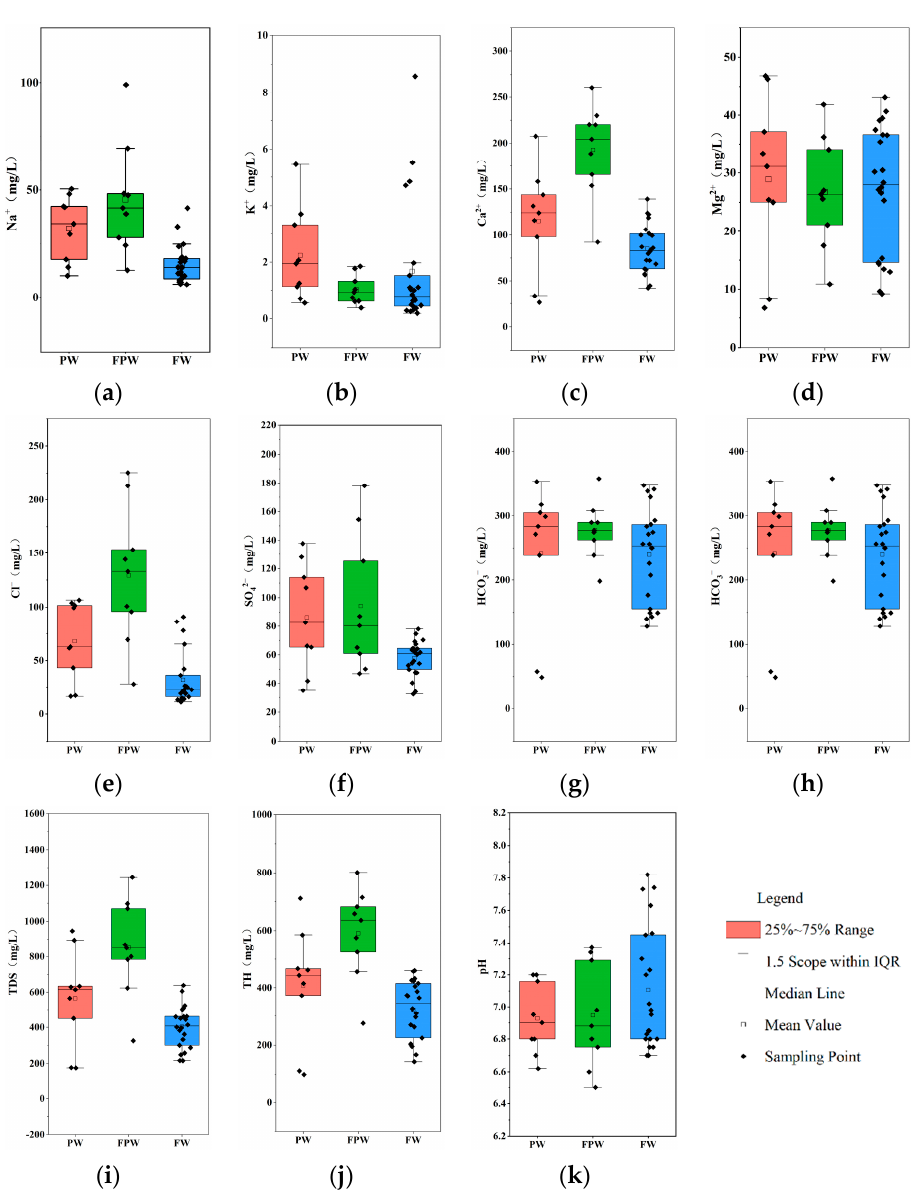
Figure 2. Box plots of the chemical contents of different groundwater types. ( a ) Na + box plot; ( b ) K + box plot; ( c ) Ca 2+ box plot; ( d ) Mg 2+ box plot; ( e ) CI − box plot; ( f ) SO 42 − box plot; ( g ) HCO 3 − box plot; ( h ) NO 3 − box plot; ( i ) TDS box plot; ( j ) TH box plot; ( k ) pH box